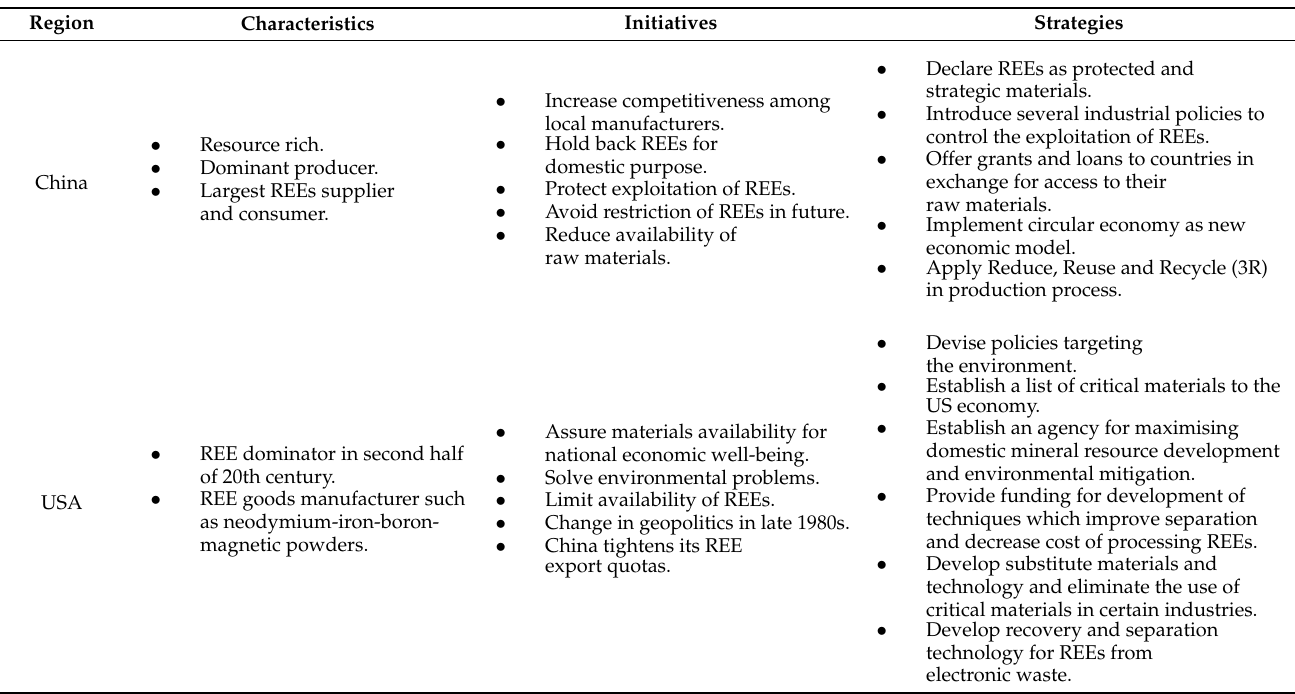
Table 1. Strategies for mitigating critical materials in the world [9].